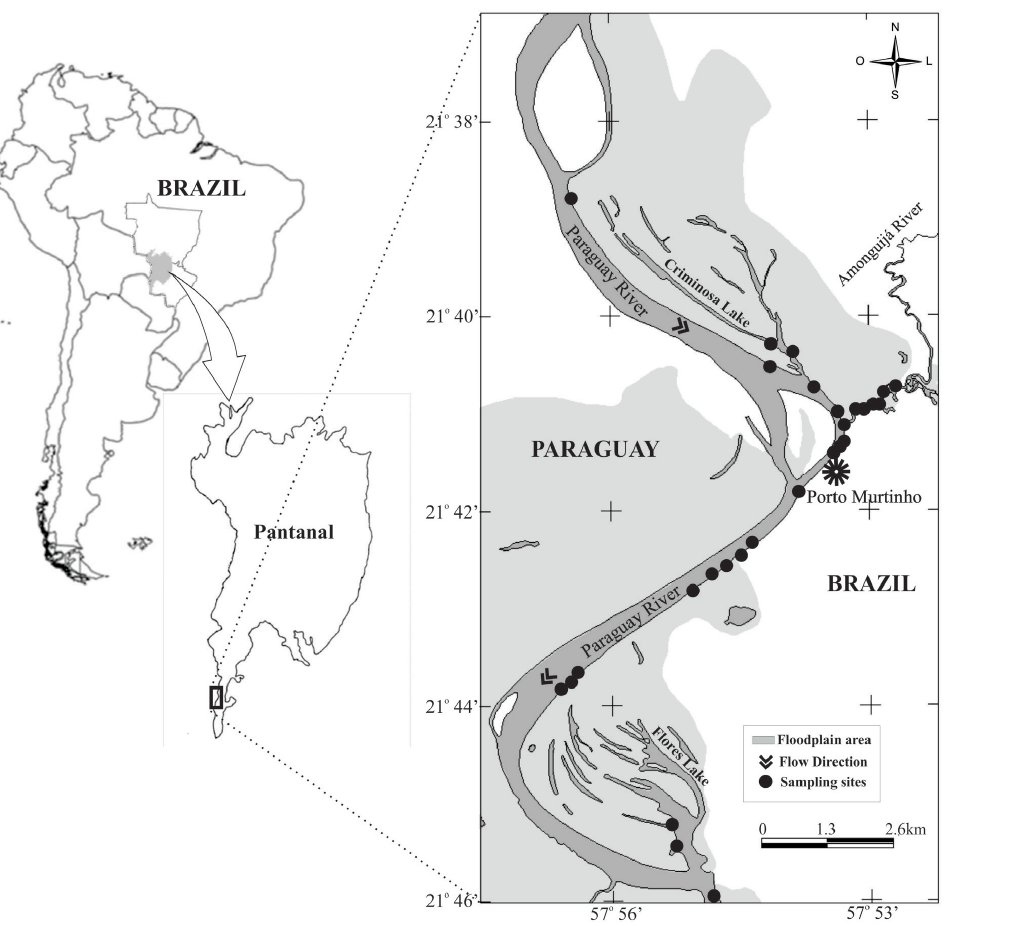
Figure 1. Sampling area at Paraguay and Amonguijá Rivers in the Southern Pantanal, Porto Murtinho, MS, Pantanal,